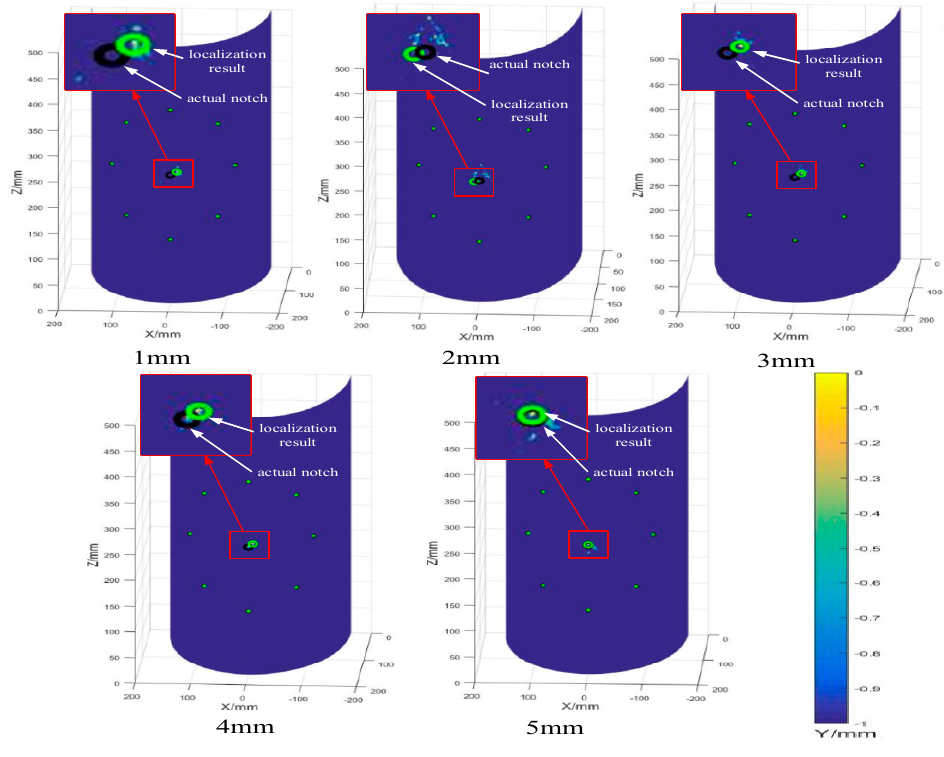
Figure 13. Damage localization results.